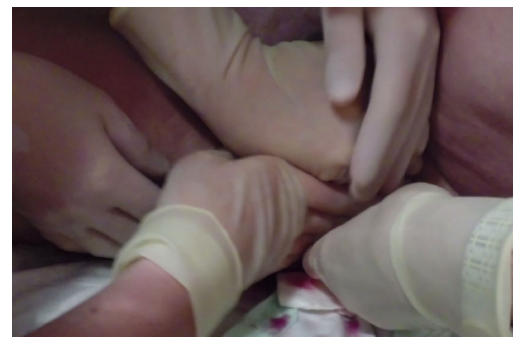
Table 1: Evaluation criteria for the video records according to the in-house standard of care. Evaluation criteria